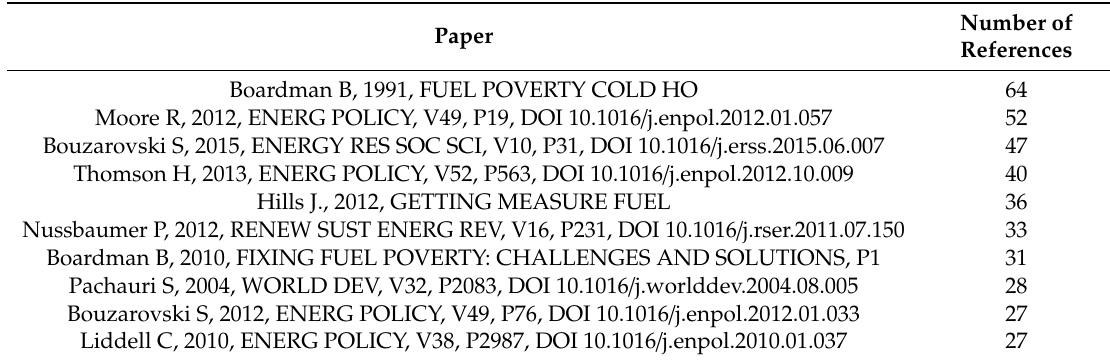
Table A5. Top 10 references on the field.